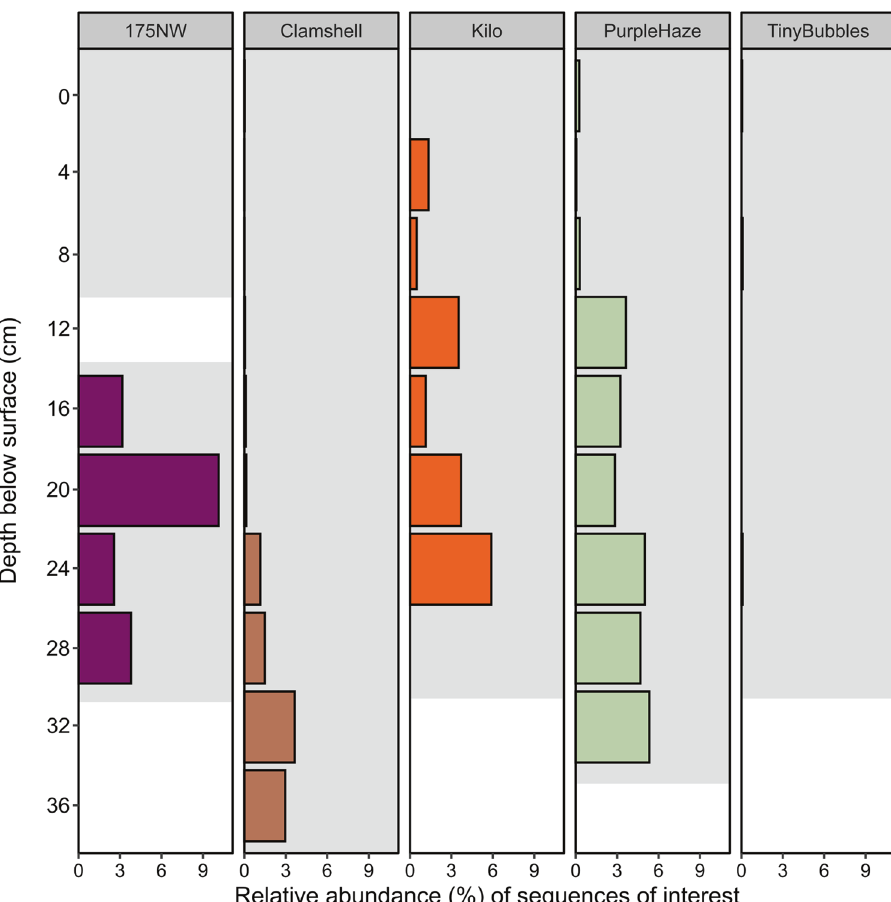
Fig. 7 Combined relative abundance and distribution of 21 taxa of interest in each sample. SituSeq Stream 2 was used to conduct a BLAST search against a custom database of species indicative of hydrocarbon seepage (Data S2). The shaded gray area shows the depths of the samples that were sequenced for each